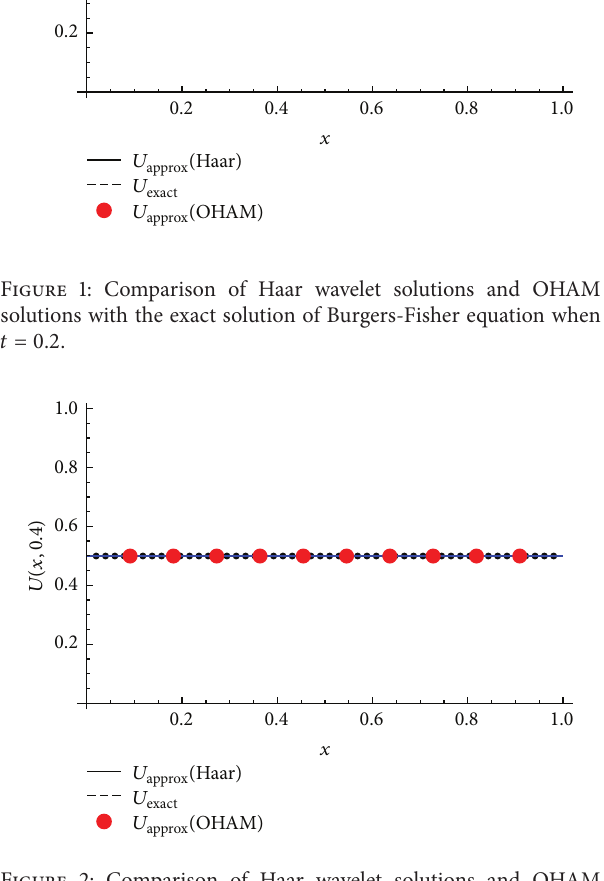
Figure 4: Comparison of Haar wavelet solutions and OHAM solutions with the exact solution of generalized Fisher’s equation when 𝑡 = 0.4